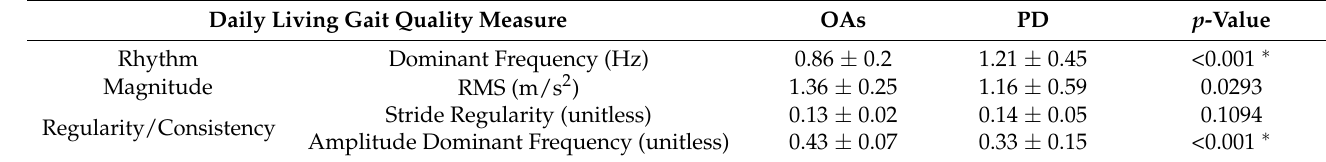
Table 7. Daily living gait quality measures in OAs compared to people with PD.